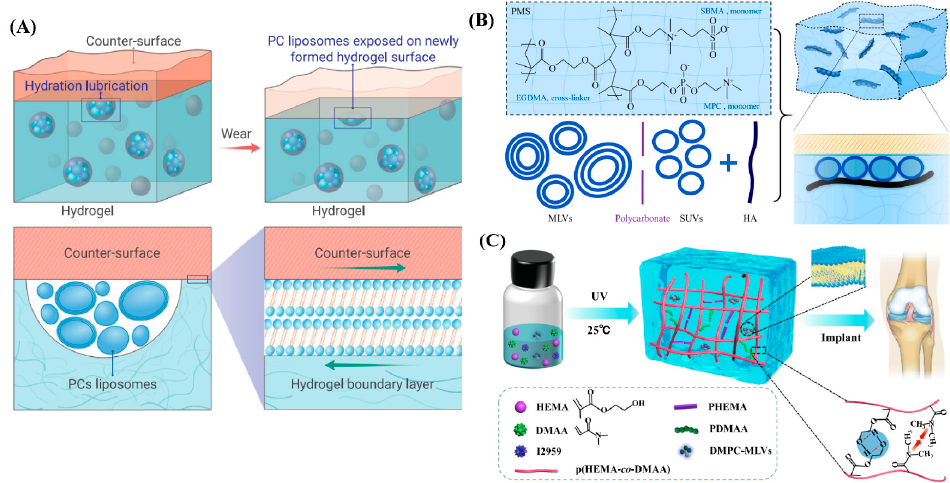
Figure 4. Phospholipid-inspired cartilage-like hydrogels. ( A ) Illustration of the self-lubricating and lipid-incorporated hydrogel. The incorporated lipids formed micro-reservoirs throughout the gel bulk, and additional micro-reservoirs were exposed due to friction, which enabled the boundary lubrication layer of the lipids to form on the surface, leading to a reduction in friction via hydration lubrication. Reprinted with permission from Ref [67]. Copyright 2022, Elsevier. ( B ) Schematic illustrating of the formation PMS-HSPC(SUV)-HA hydrogel and the synergistic lubrication mechanism. The super- lubricated state after the incorporation of lipid SUV and HA was mainly attributed to the synergistic lubrication effect between lipids and HA after the formation of uniformly arranged lipid